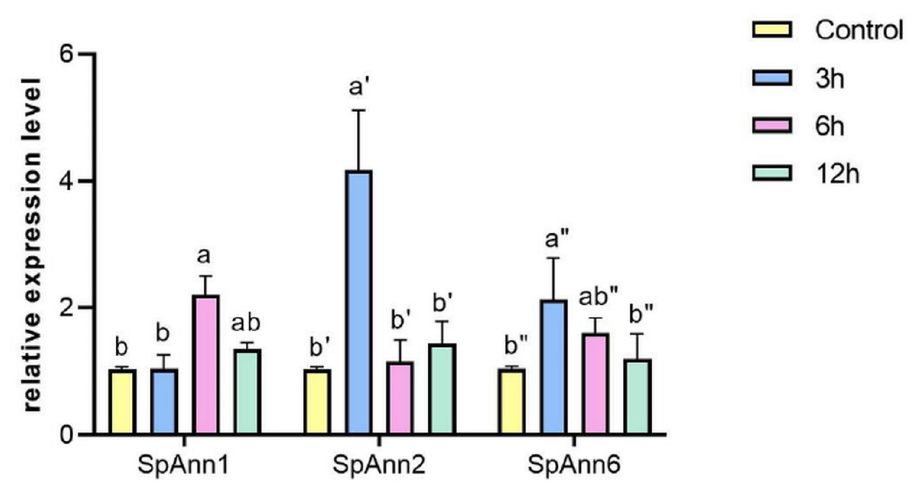
Fig 8. Expression of selected of S . parvula Anns under Salt stress treatments. Three-weeks old seedlings were treated with 200 mM NaCl for 3 h, 6 h, and 12 h. The expression level was normalized against Act 7 gene. Different letters represent statistically significant differences (P �